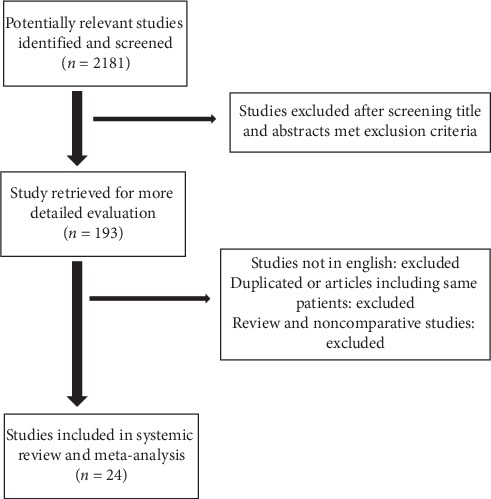
Prisma flow chart.